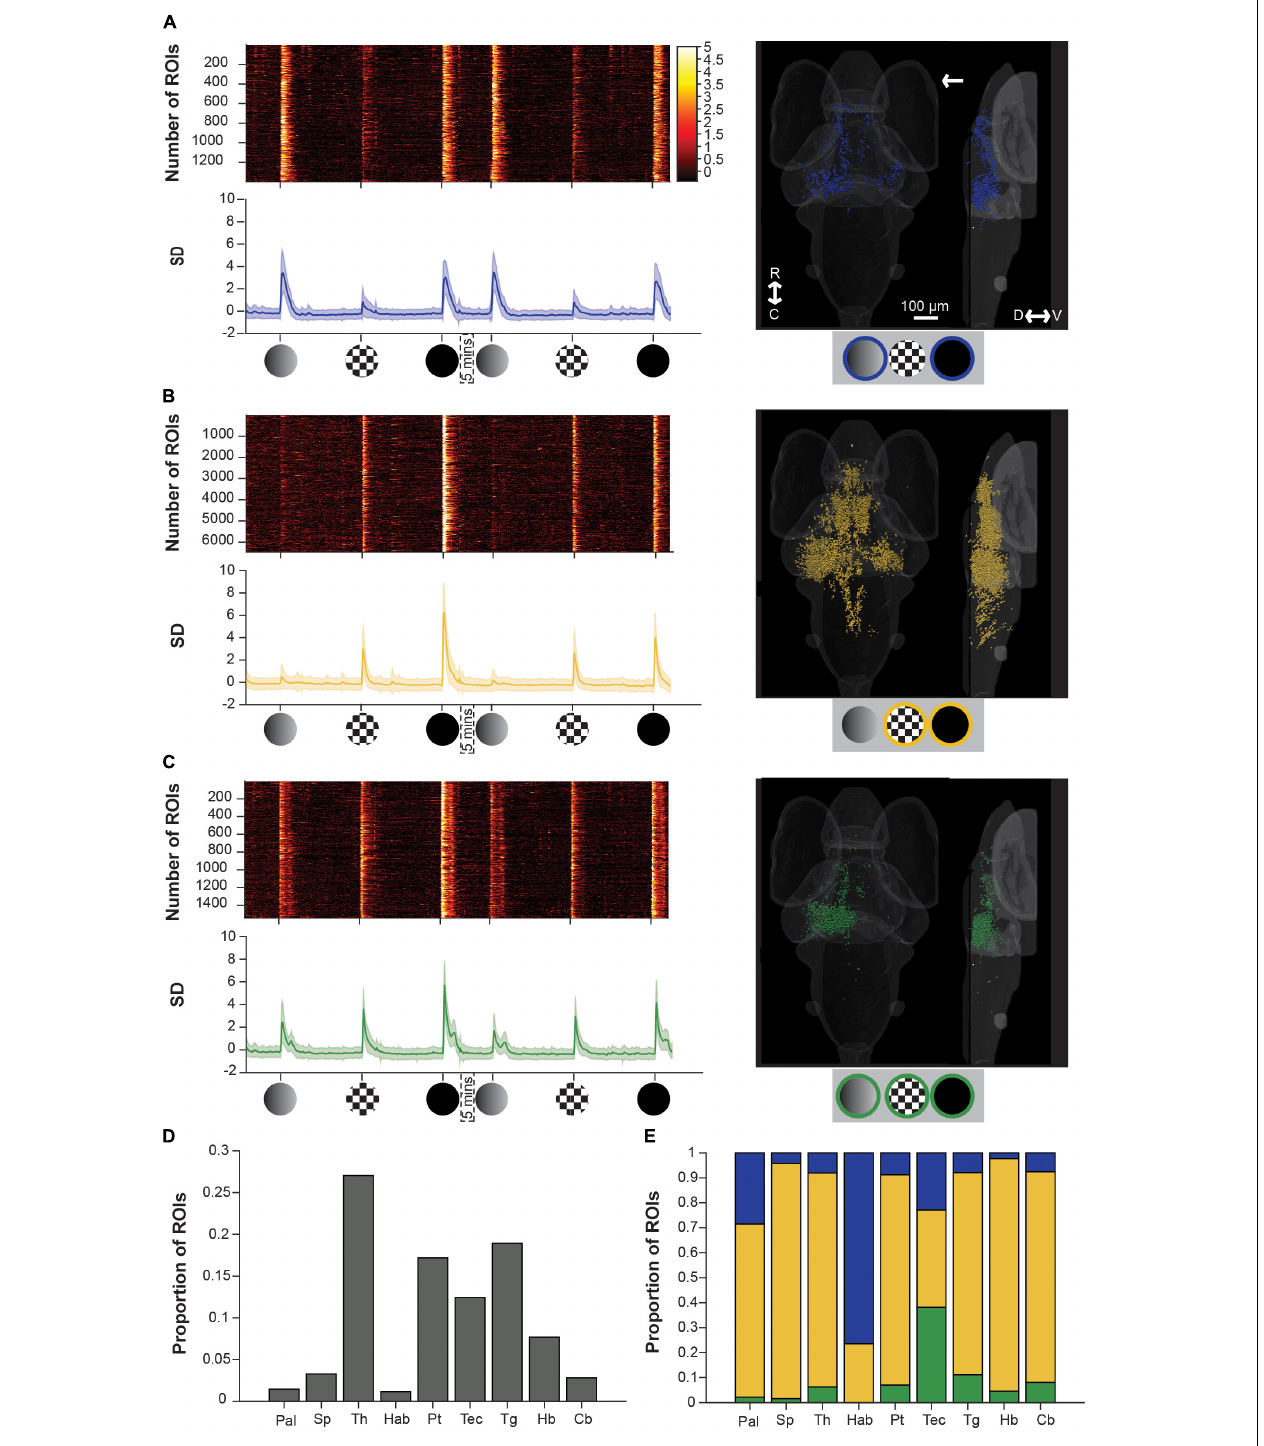
FIGURE 3 | Brain-wide calcium responses to dim, checkerboard, and loom stimuli. (A) A raster plot (top left), average trace with S.D. shaded (bottom left) and transverse and lateral spatial distributions (right) of ROIs responsive to dim and loom stimuli. Response strengths are shown in S.D., and the arrow shows the position of the stimulus presentation. (B) Shows the same information for ROIs responsive to checkerboards and looms, and panel (C) shows this information for ROIs responsive to all three stimuli. (D) Average proportion of ROIs within each brain region that are visually responsive. (E) Average proportion of visually responsive ROIs within each brain region that are either dim sensitive (blue), checkerboard sensitive (yellow), or sensitive to both dim and checkerboard (green). R, rostral; C, caudal; D, dorsal; V, ventral; Pal, pallium; Sp, subpallium; Th, thalamus; Hab, habenula; Pt, pretectum; Tec, tectum; Tg, tegmentum; Hb, hindbrain; Cb, cerebellum.